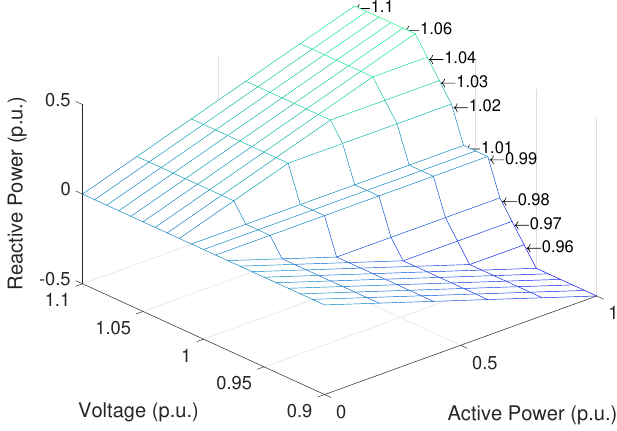
Figure 6. Droop curve of reactive power